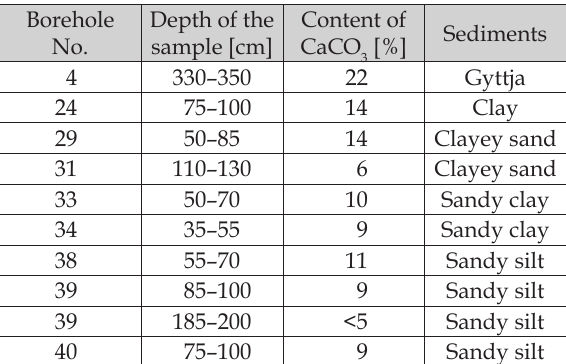
in particular 3